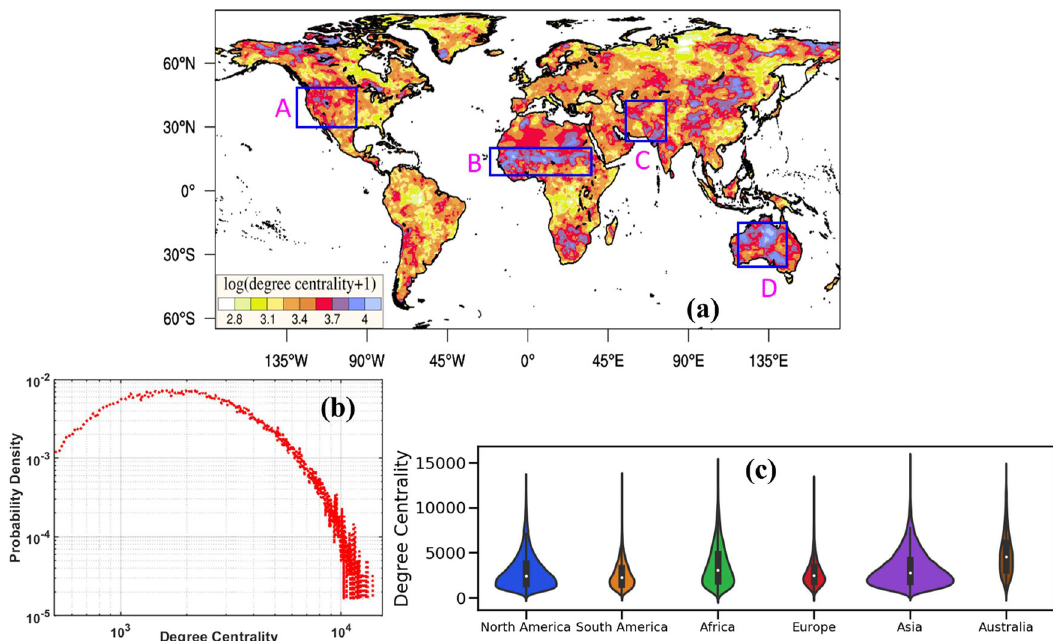
Fig. 1 | Spatiallinkagesamong globaldroughts.a Degree centralityofthe global droughtnetwork,BoxA-D:regionswithhighspatiallinakge(ordegreecentrality) b degree distribution ofthe global drought network on a log-log scale with the thick